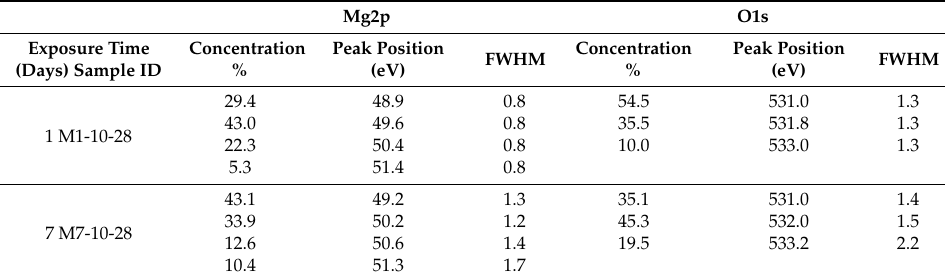
Figure 13. Mg2p concentration for samples exposed to 10% CO 2 for one and seven days.